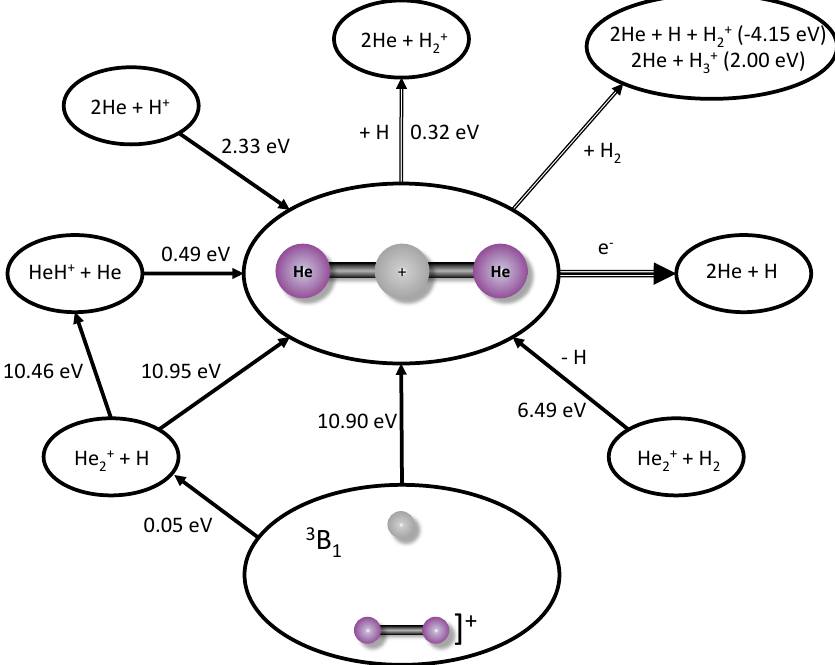
Figure 2. The pathways and ZPVE-corrected energetics for the creation and destruction of 1 Σ + g HeHHe + . Positive energies favor the products based on the direction of the arrow. Negative energies favor the